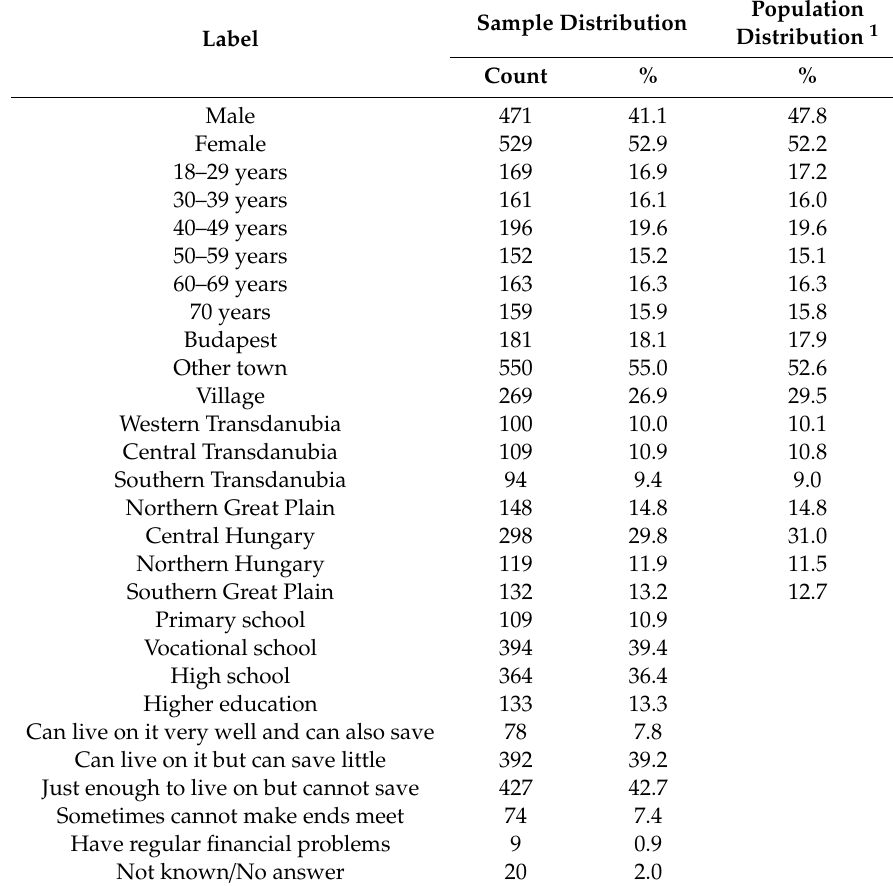
Table 1. Distribution of the sample according to the most important background variables ( N = 1000) and population composition according to representative variables.